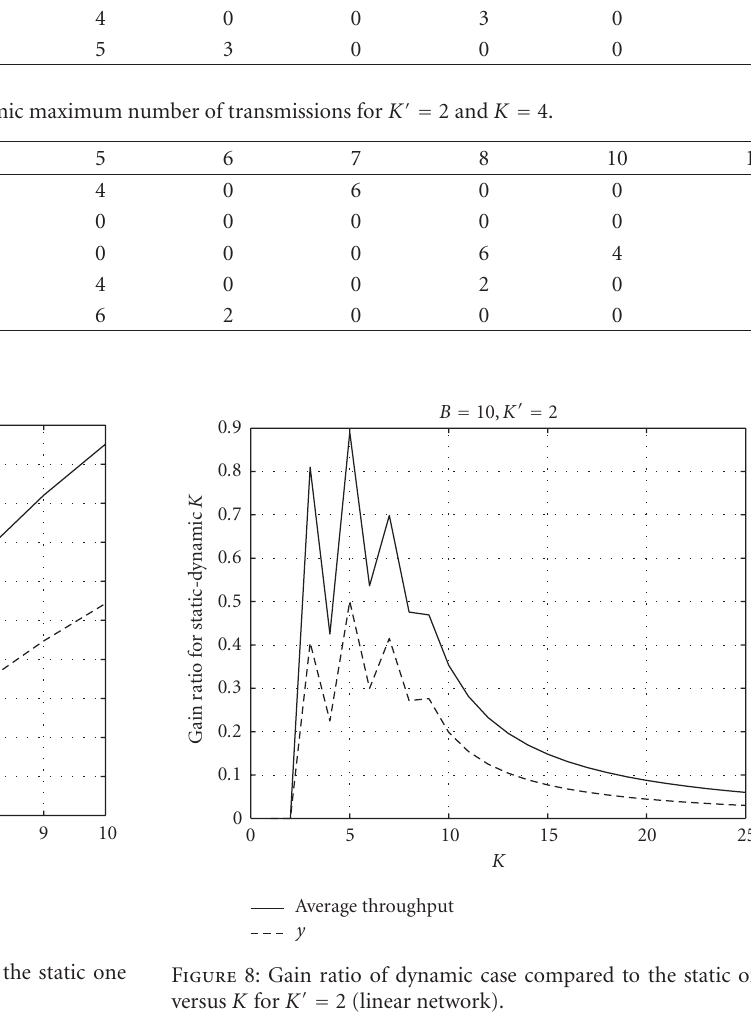
Table 1 for K (cid:5) = 1 and Table 2 for K (cid:5) = 2). Note that “Conn.” means “connection.” In fact, there are two advantages on